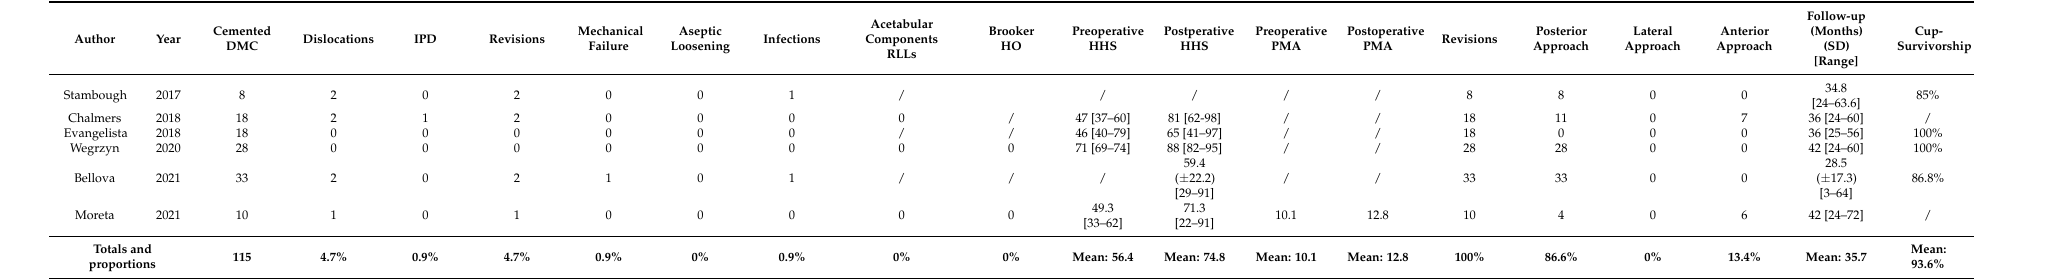
Table 10. Cemented DMC: cup-in-cup